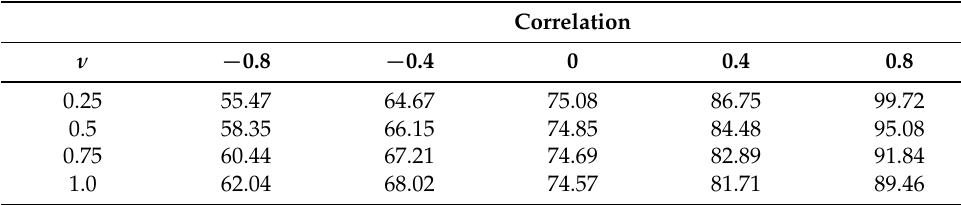
Table 2. Product of two calls.